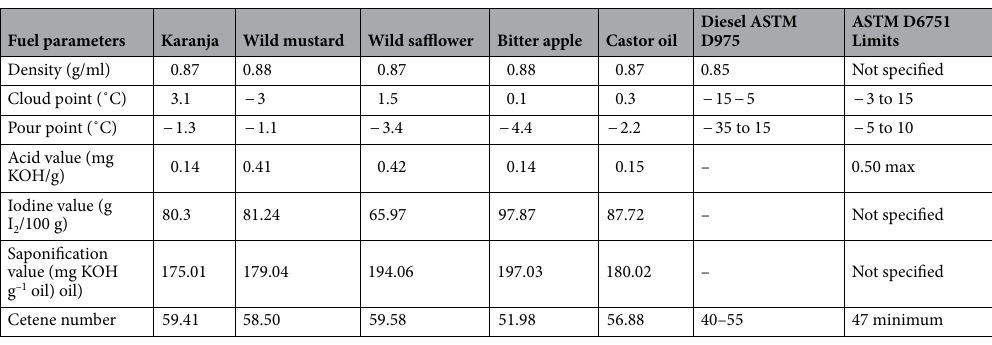
Table 9. Comparison of fuel properties of FAME from karanja, wild mustard, wild safflower, bitter apple, and castor seed oils with